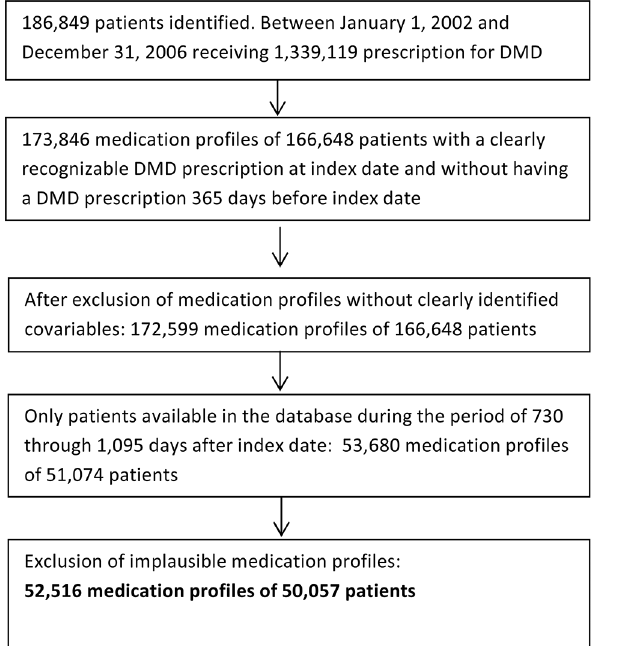
Fig 2. Flow chart of inclusion and exclusion criteria and remaining medication